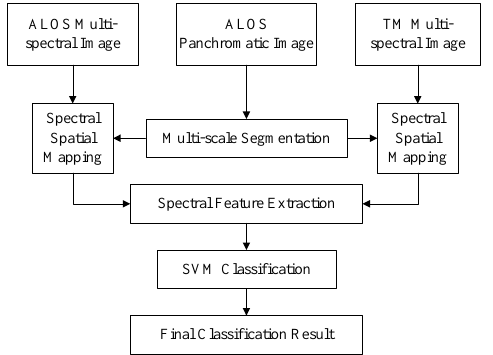
Figure 1. The flow chart of the proposed classification